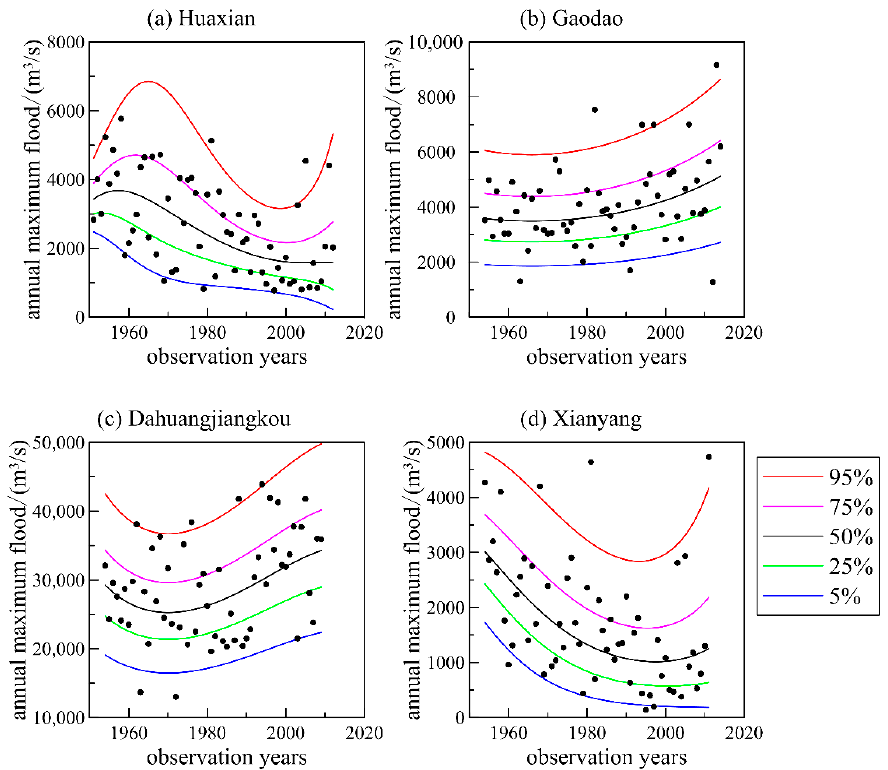
Figure 5. Quantile curves of QR-CB model for ( a ) Huaxian station; ( b ) Gaodao station; ( c ) Figure 5. QuantilecurvesofQR-CBmodelfor( a )Huaxianstation; ( b )Gaodaostation; ( c )Dahuangjiangkou Dahuangjiangkou station; ( d ) Xianyang station. station; ( d ) Xianyang station.